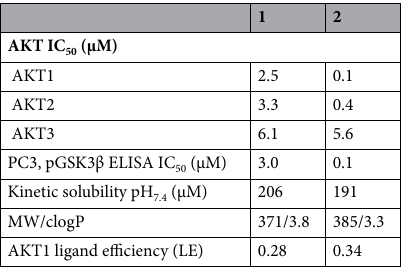
Table 1. Potency and physicochemical characterization of initial leads.